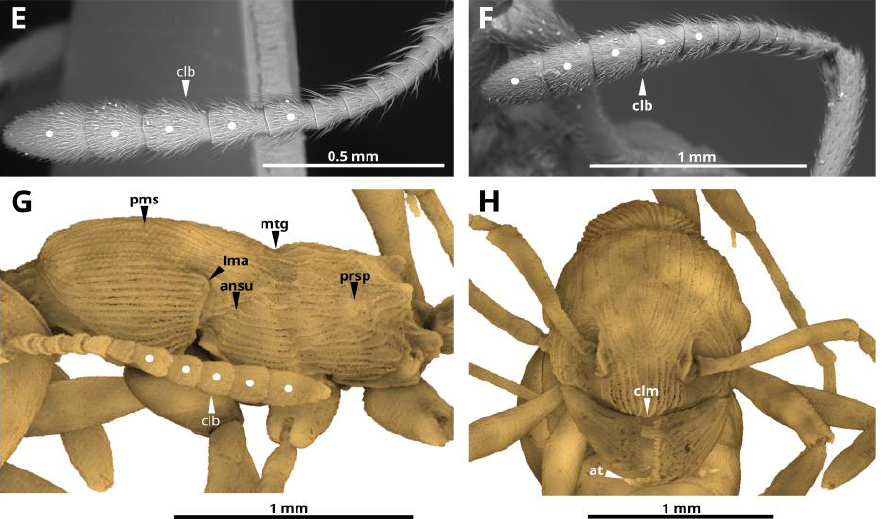
Figure 3. Select key features of the Manica species. SEM micrographs of M. invidia ( A , B , E ), M. rubida ( C , D , F ) and µCT volume rendering of † M. andrannae sp. n. ( G , H ). Worker: A , C , G — mesosoma, left